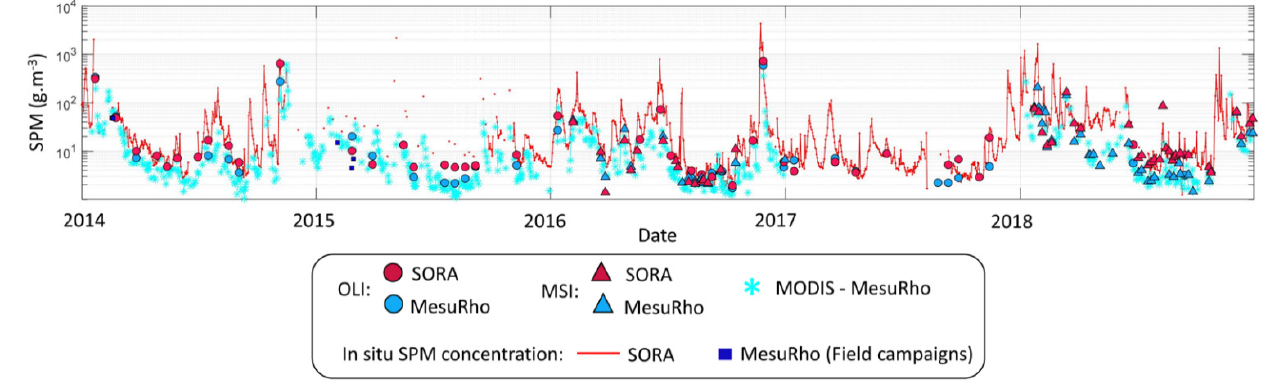
Figure 8. Satellite-derived SPM SA concentration at the SORA station (red markers) and MesuRho (blue markers) locations estimated from the three sensors from 2014 to 2018 compared to in situ SPM concentration (SORA: red line; MesuRho (field campaigns): dark blue squares).